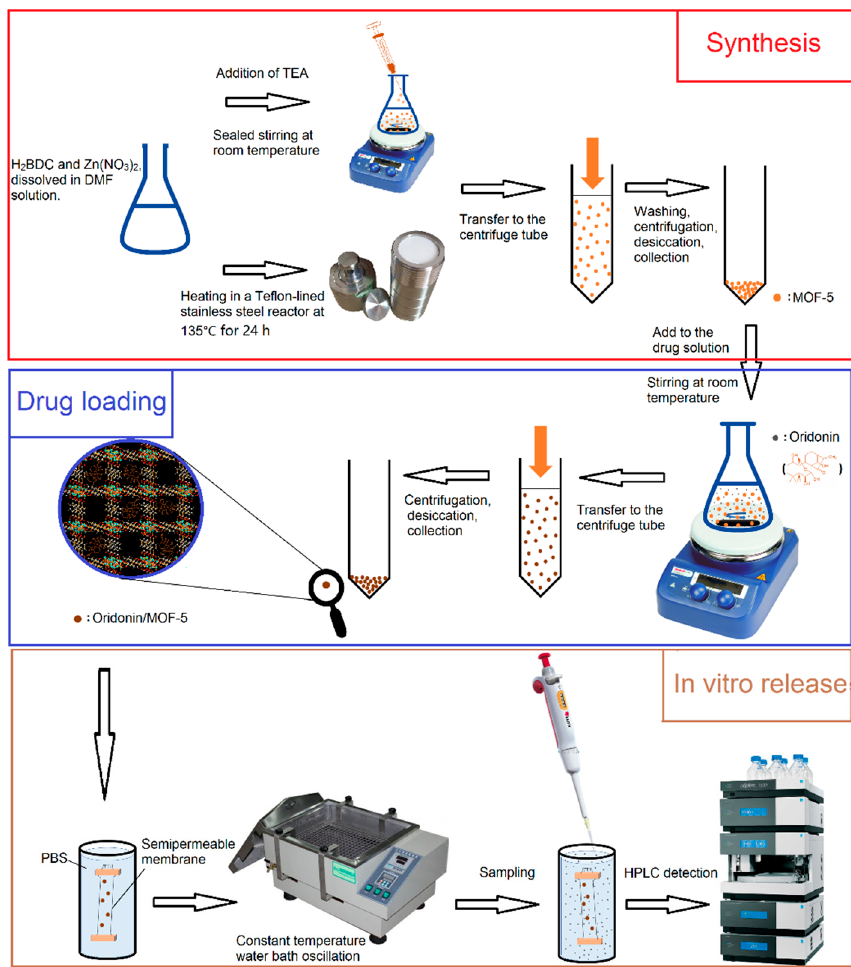
Figure 3. The flow chart for synthesis, drug-loading, and in vitro release.